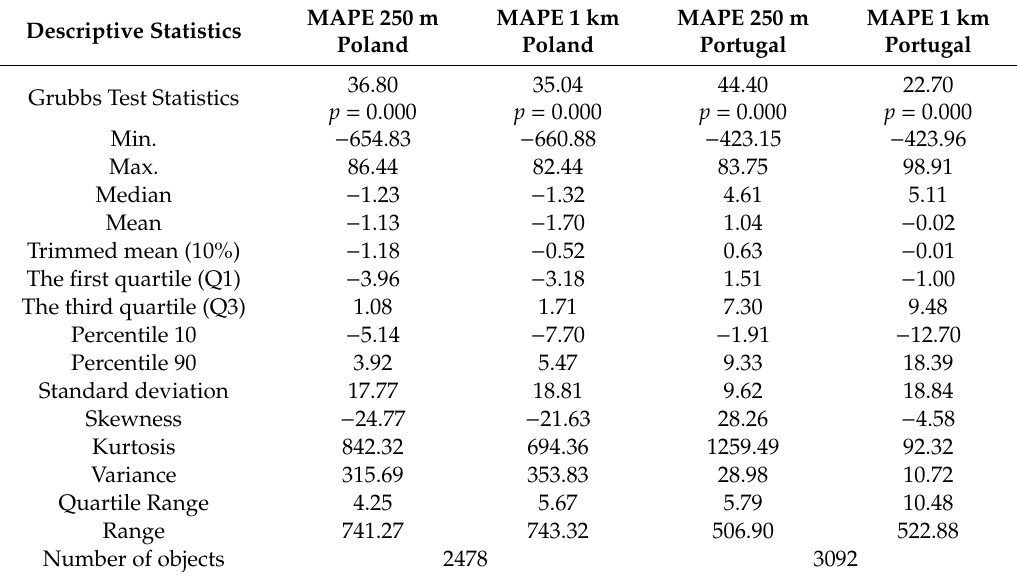
Table 5. Descriptive statistics for MAPE for LAU 2 (NUTS